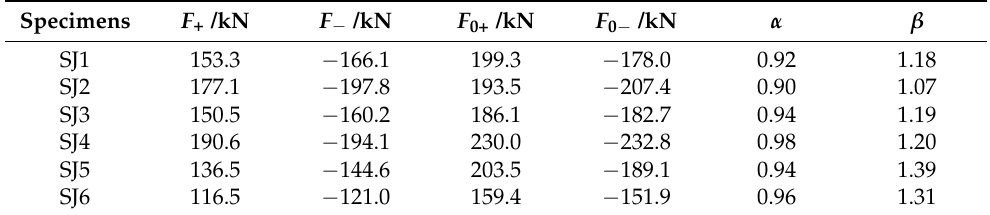
Table 2. The friction non-uniformity coefficient α and the influence coefficient of the maximum static friction force β .